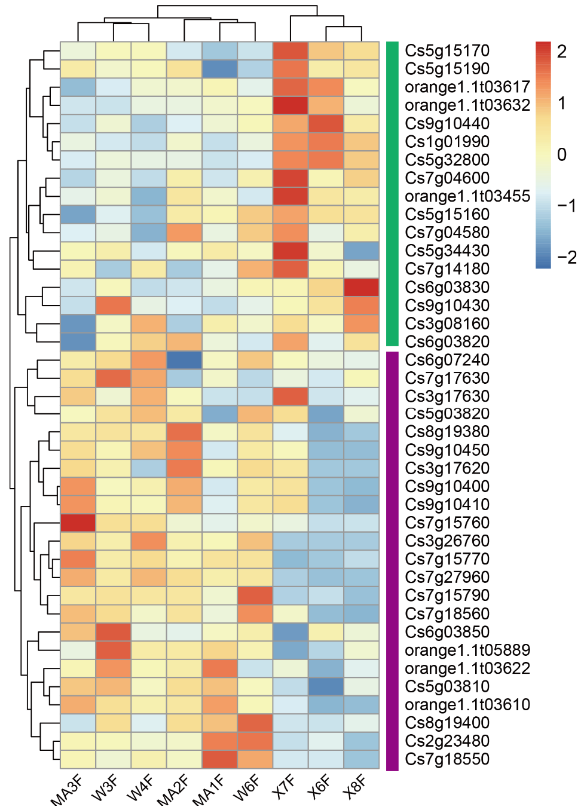
Figure A8. Heatmap base on genes expression of glutathione S-transferase genes.